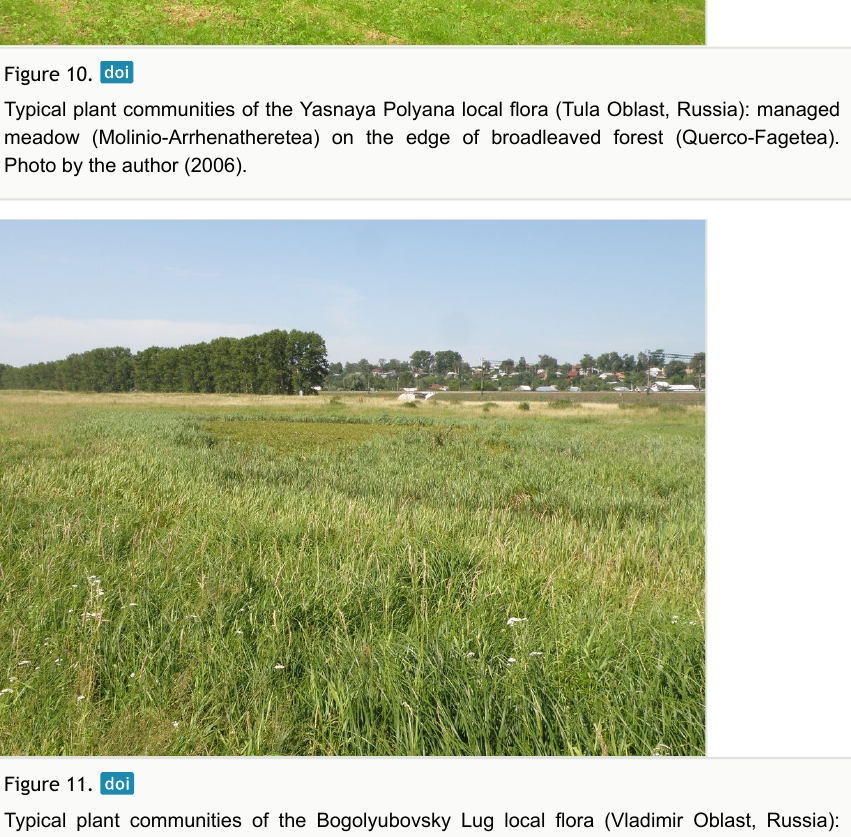
Typical plant communities of the Bogolyubovsky Lug local flora (Vladimir Oblast, Russia): Stratioites aloides L. community (Lemnetea) surrounded by Phragmito-Magnocaricetea swamp and Molinio-Arrhenethretea meadows on flood plain of the Klyazma River. Photo by the author